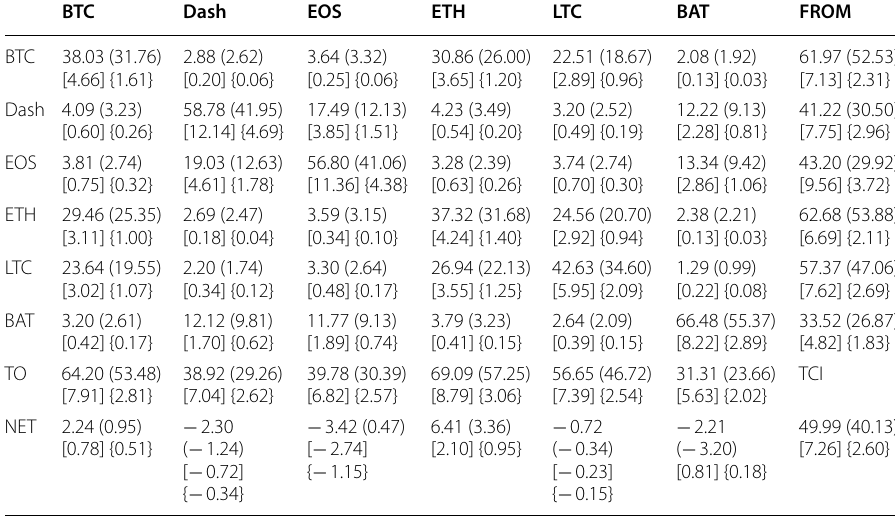
The values in parentheses (), square brackets [], and curly brace {} denote the short‑term (1–5 days), medium‑term (5–22 days), and long‑term (more than 22 days) frequency connectedness results